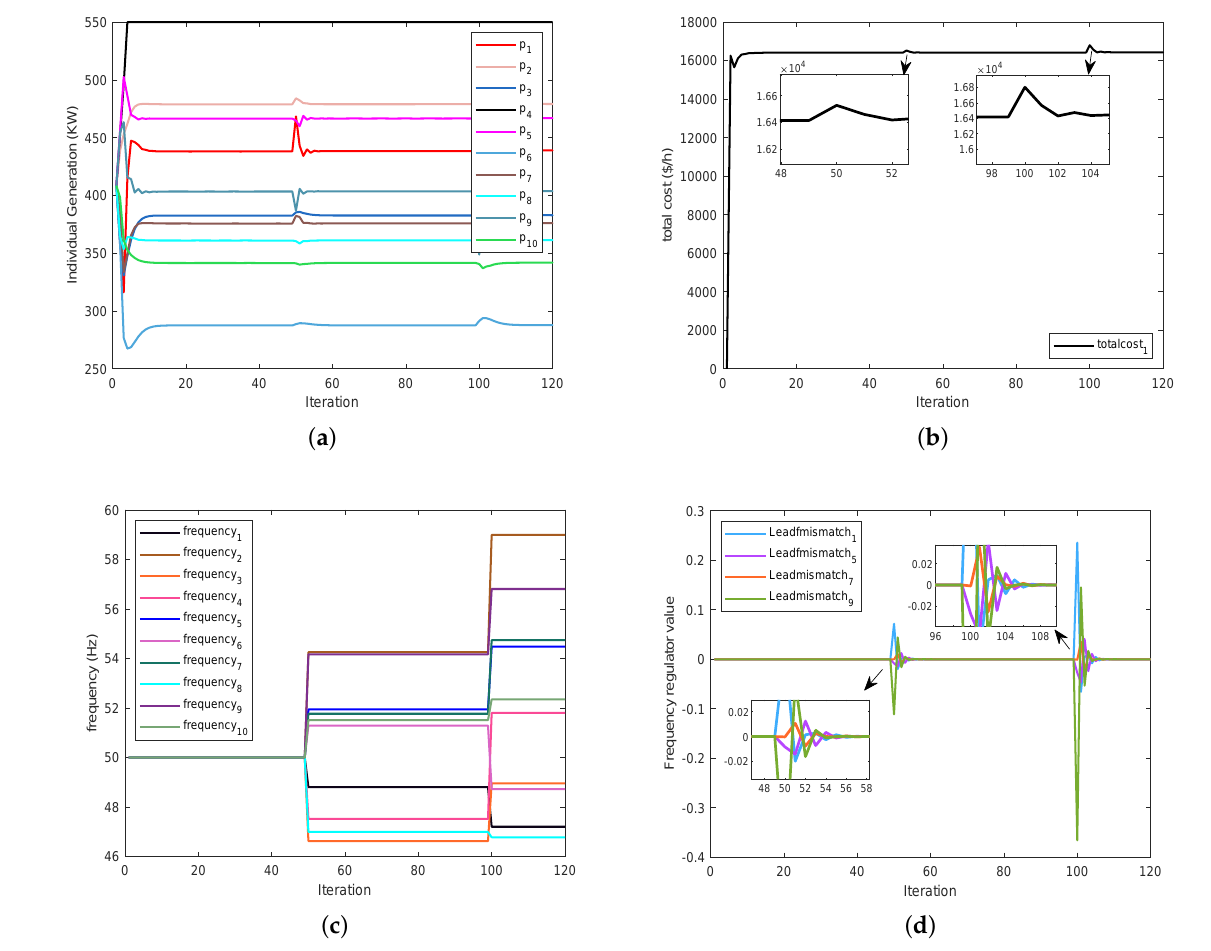
Figure 6. ( a ) The output power of each generator P i ( k ) . ( b ) The total cost of power generatio. ( c ) The frequency variation process F i ( k ) . ( d ) The process of frequency